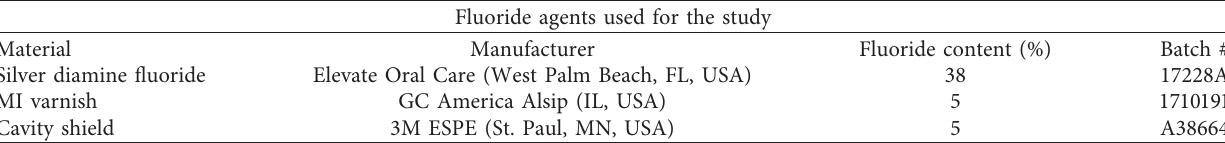
Table 1: Fluoride agents used for the study.